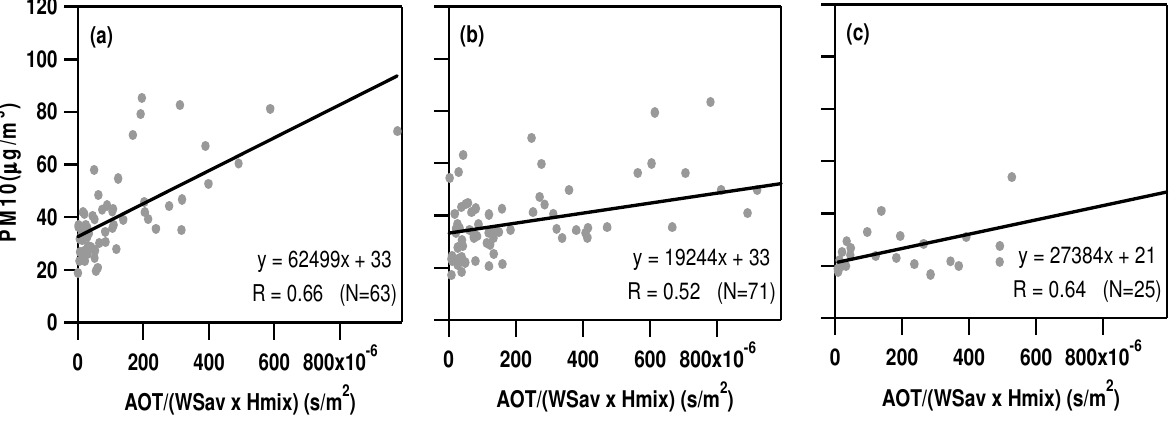
Figure 14. Scatterplot of Arnesano-PM10 mass concentrations versus clear-sky AOTs divided by the (WSav × Hmix) product for (a) 2006, (b) 2007, and (c) 2008. Slope, intercept and linear correlation coefficient ( R ) are also given in each plot in addition to the total number of data points ( N ).